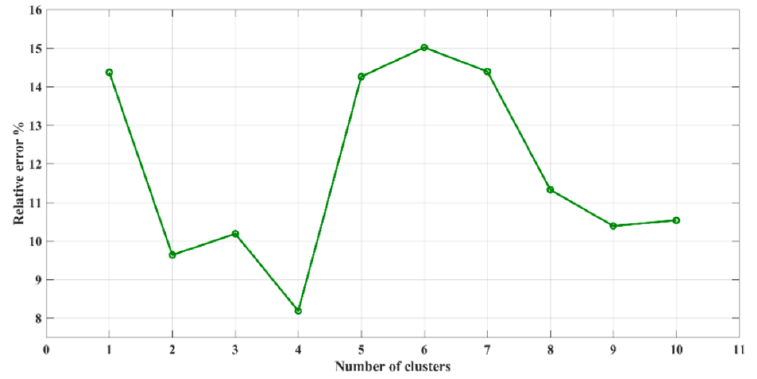
Figure 13. The error for different numbers of clusters [15].